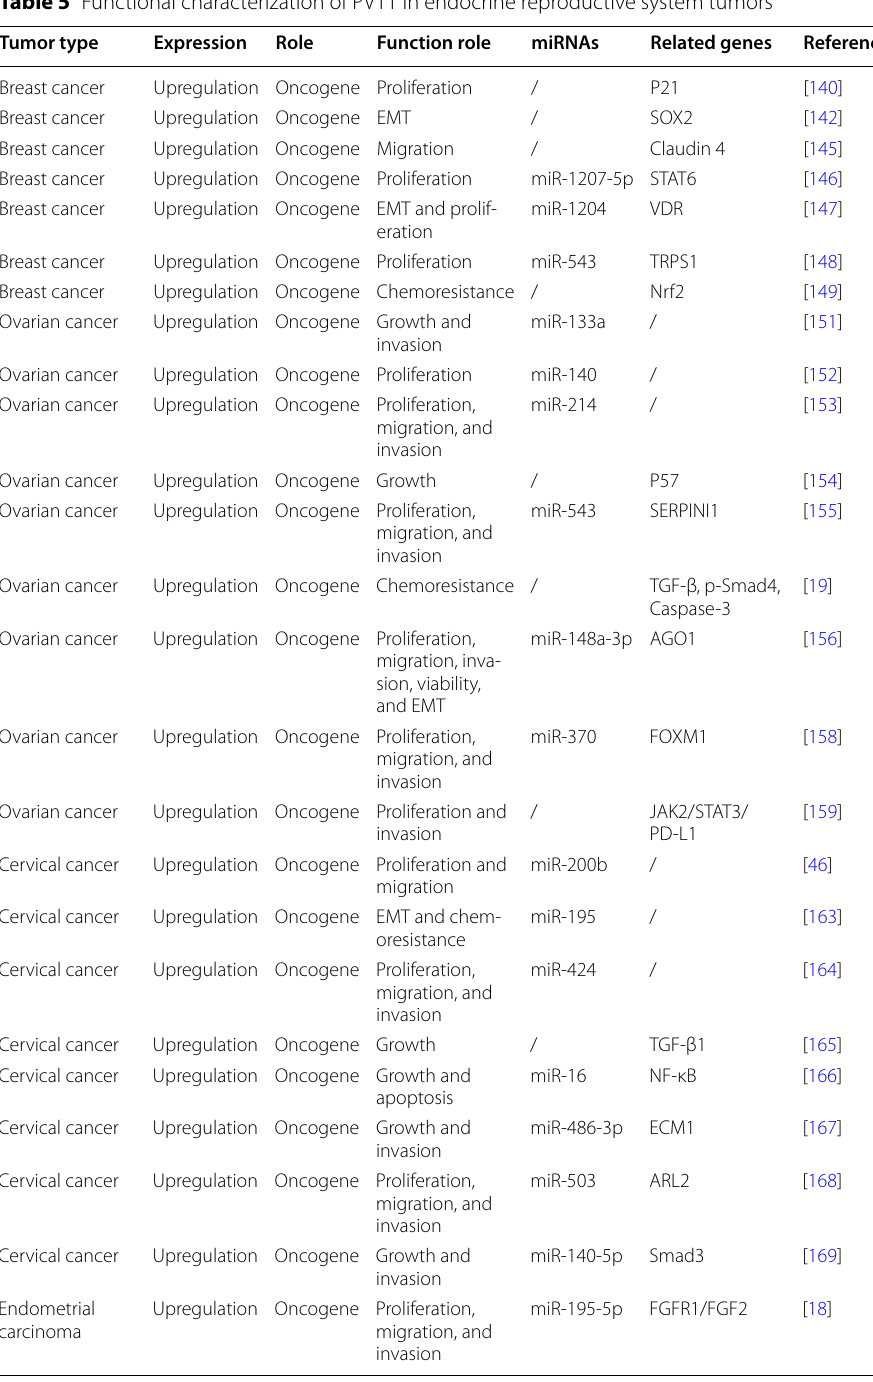
Table 5 Functional characterization of PVT1 in endocrine reproductive system tumors Tumor